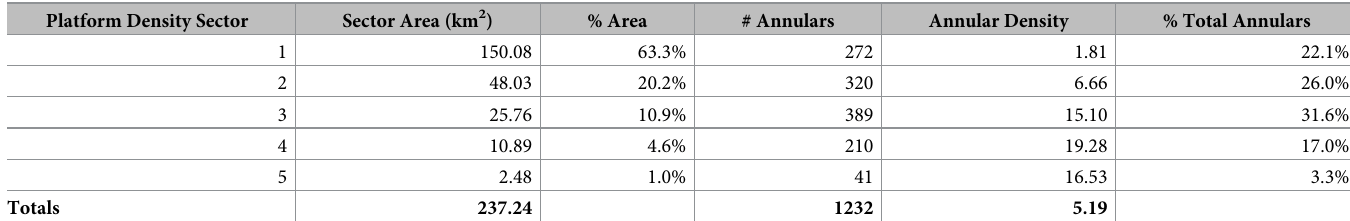
Table 7. Annular counts/density in platform density sectors (see Table 4).